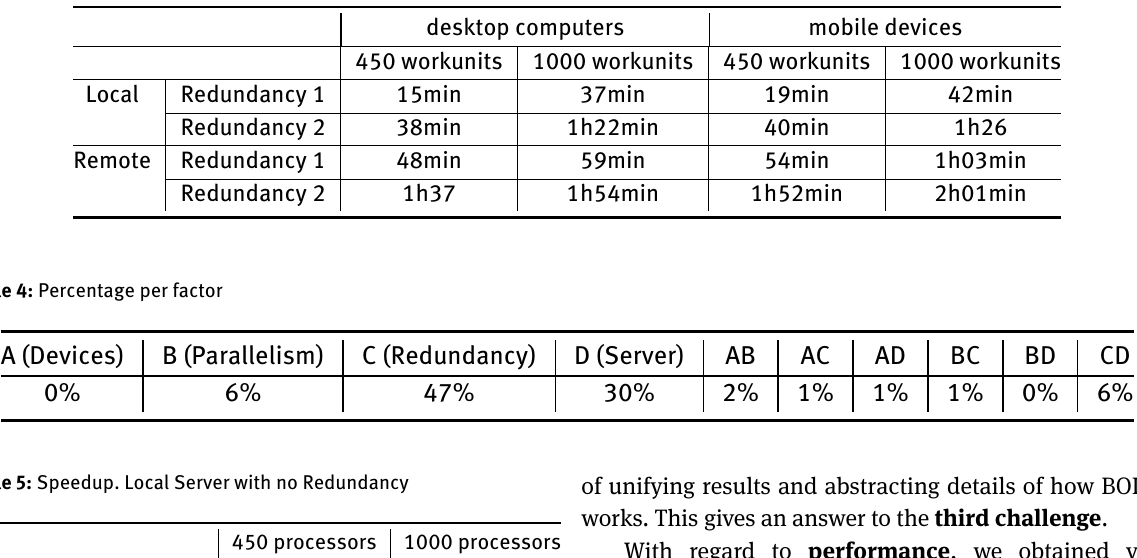
Table 3: Results of the 2 k experiment